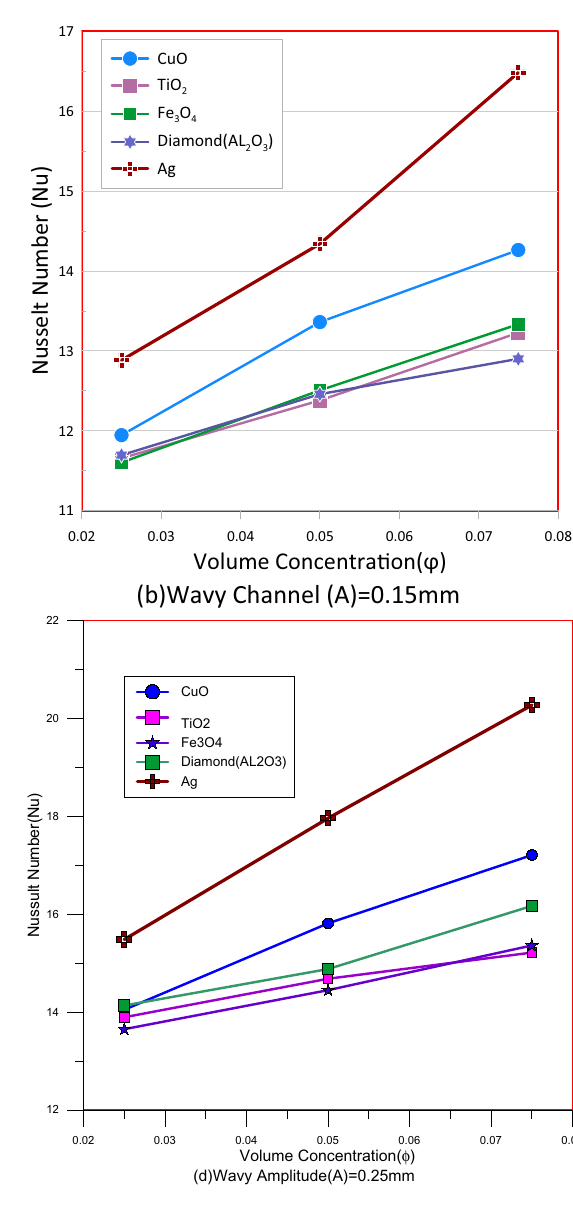
Figure 16. Show Nusselt number (Nu) versus Volume concentration for different